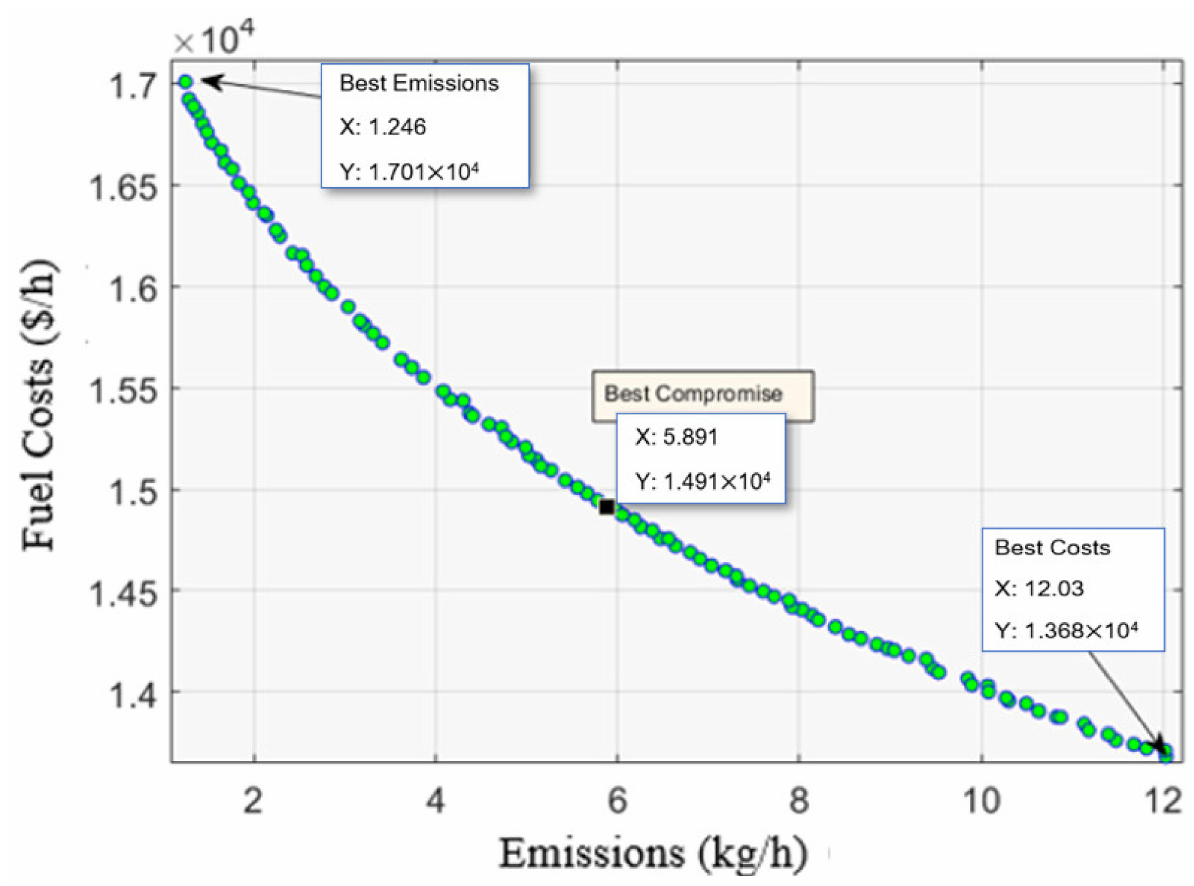
Figure 4. Final Pareto set with the proposed MTLSBA for the CHPEED